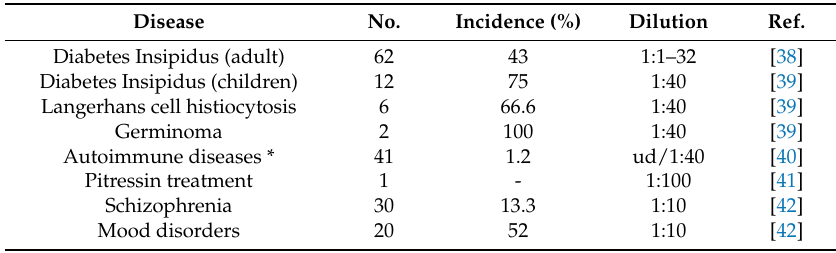
Table 2. Incidence of AHAs in autoimmune and no-autoimmune